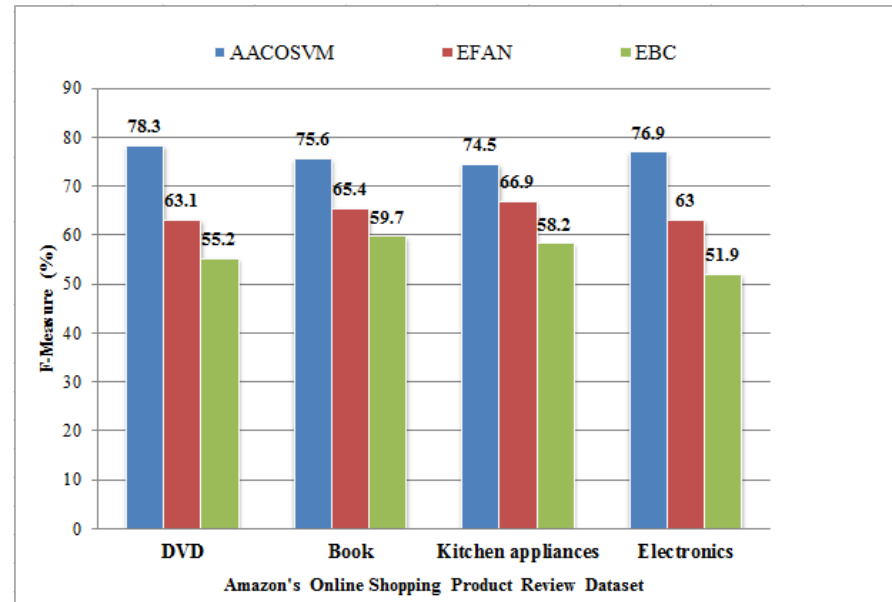
Figure 1: F-Measure vs. AACOSVM Figure 1. F-Measure vs. AACOSVM.